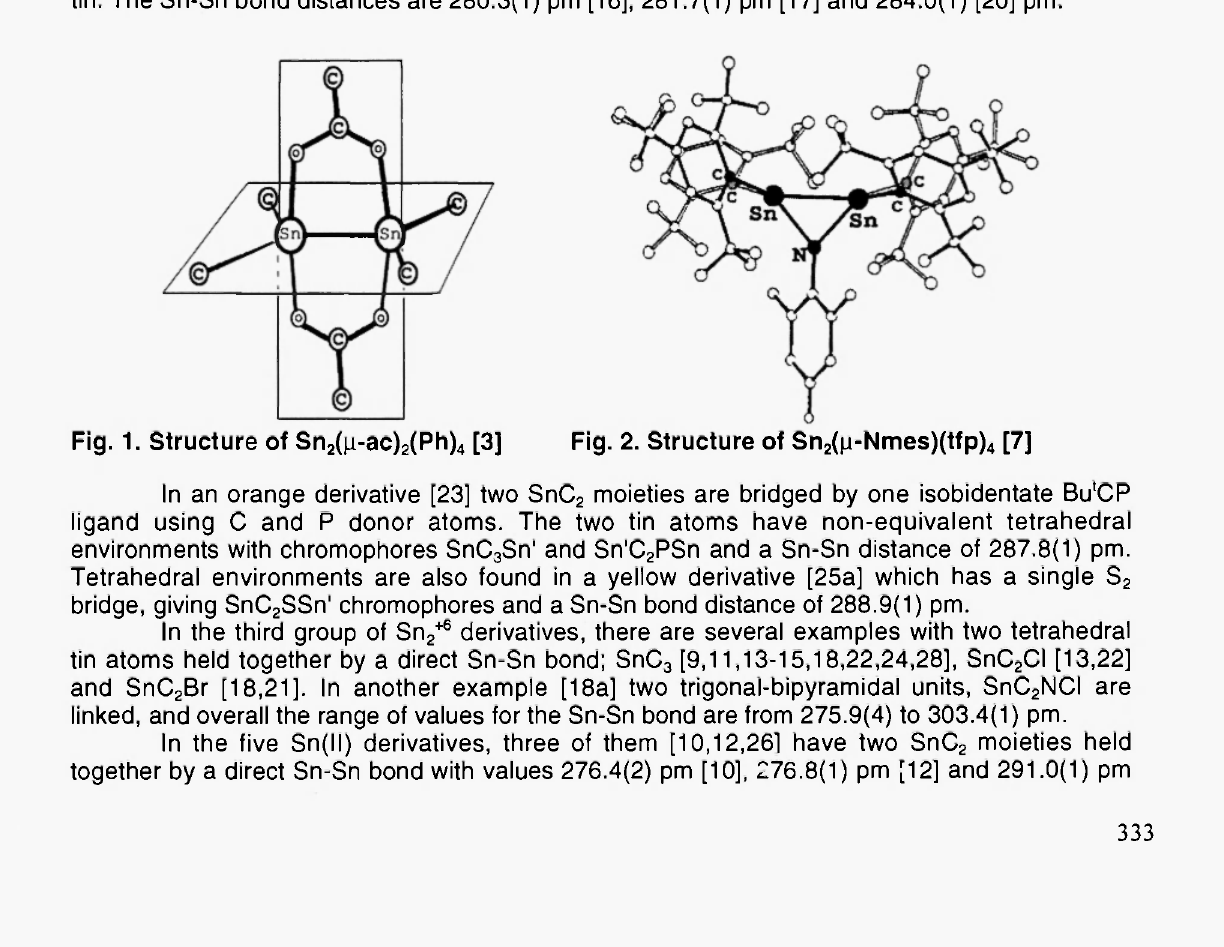
Fig. 1. Structure of Sn 2 ^-ac) 2 (Ph) 4 [3] Fig. 2. Structure of Sn 2 (p-Nmes)(tfp) 4